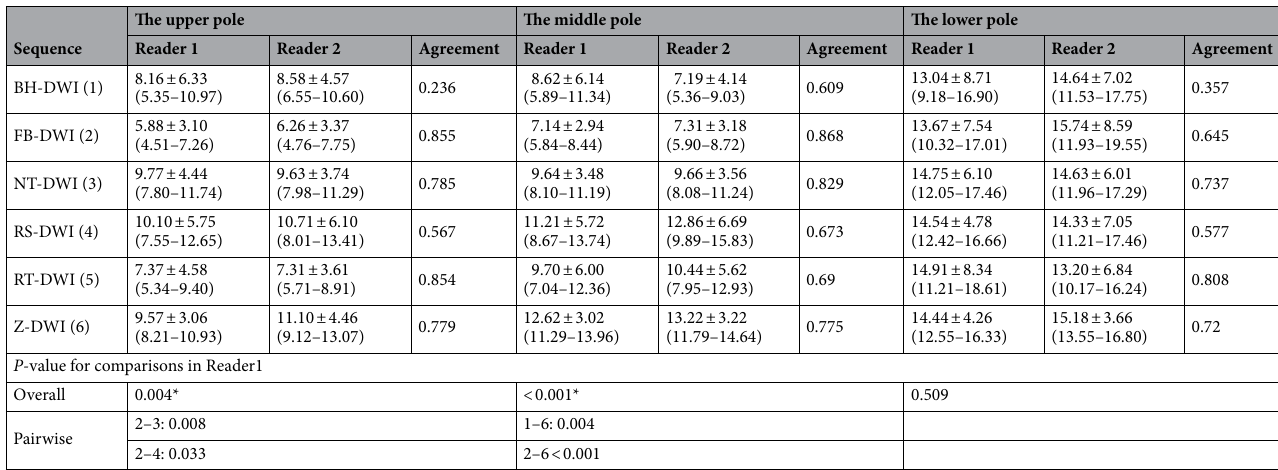
Table 3. Cortico-medullary contrast to noise ratio (c-mCNR) of right kidney. P < 0.05 were considered significant difference (*). P values were presented only when they were less than 0.05. c-mCNR (Cortico- medullary contrast to noise ratio) was measured in different anatomical regions with b = 800 s/mm 2 images. Mean values of c-mCNR with the standard deviation and 95% confidence interval in parentheses are shown. At the bottom, P -values for the overall comparisons using Friedman test are given in reader1. If the Friedman test found a statistically significant P -value, additional P -value was presented with all pairwise comparisons by the Dunn-Bonferroni post-hoc test. BH-DWI breath-hold DWI, FB-DWI free-breathing DWI, NT-DWI navigator-triggered DWI, RS-DWI readout-segmented DWI, RT-DWI respiratory-triggered DWI and Z-DWI Zoomit DWI.